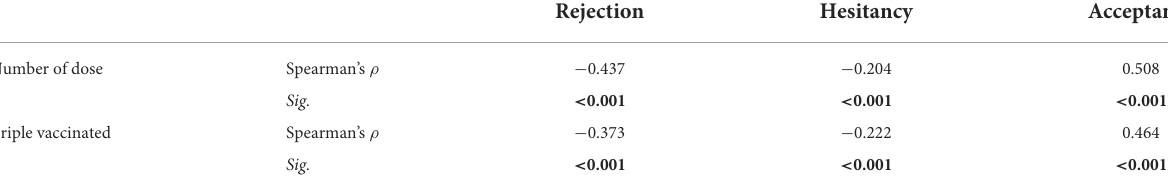
TABLE 7 Correlation between vaccine doses & willingness to receive COVID-19 vaccine booster doses.